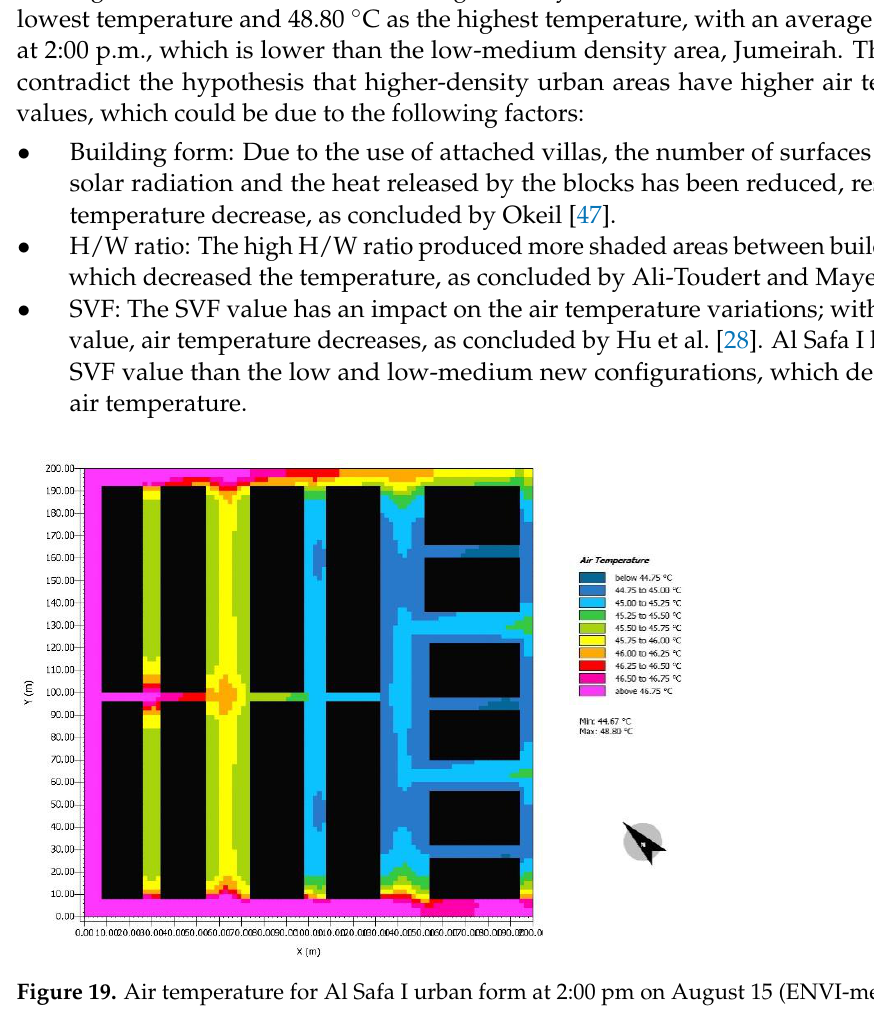
Figure 20. Wind speed and direction for Al Safa I urban form at 2:00 pm on August 15 (ENVI-met).